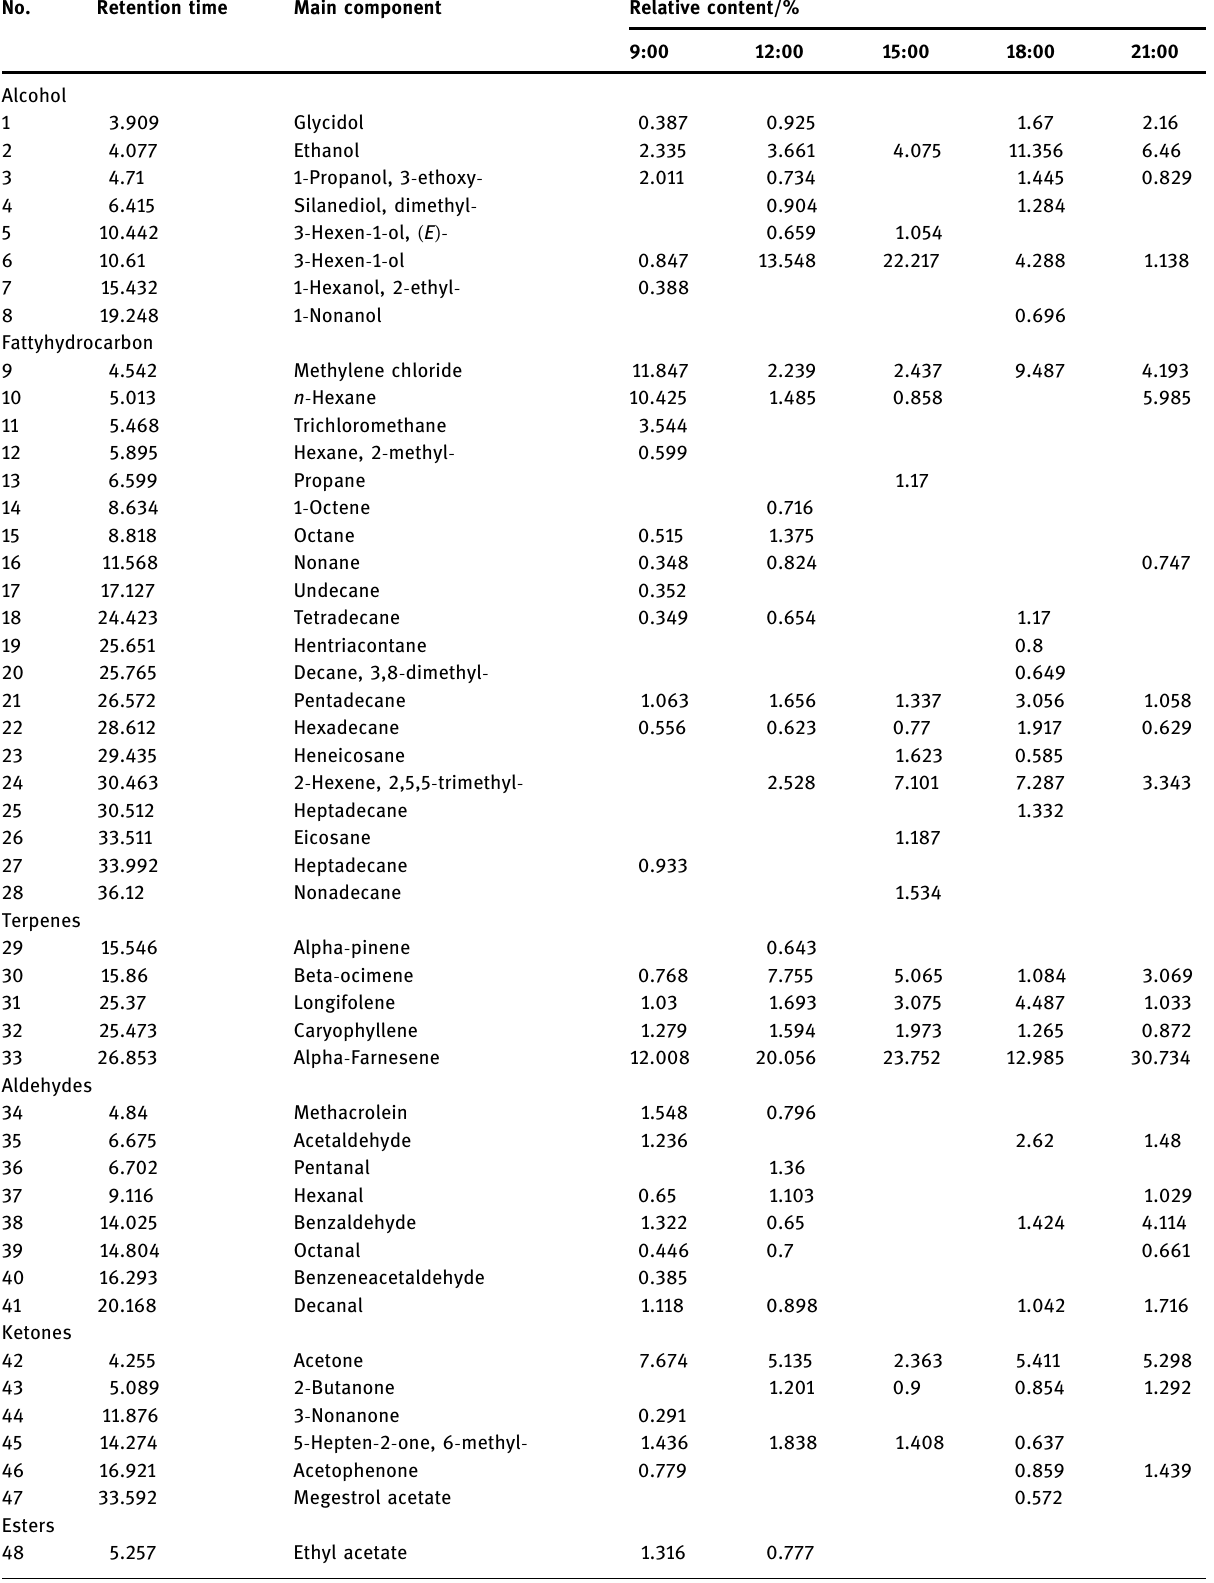
Table 2: Analysis result of fl oral composition and relative content of tulip